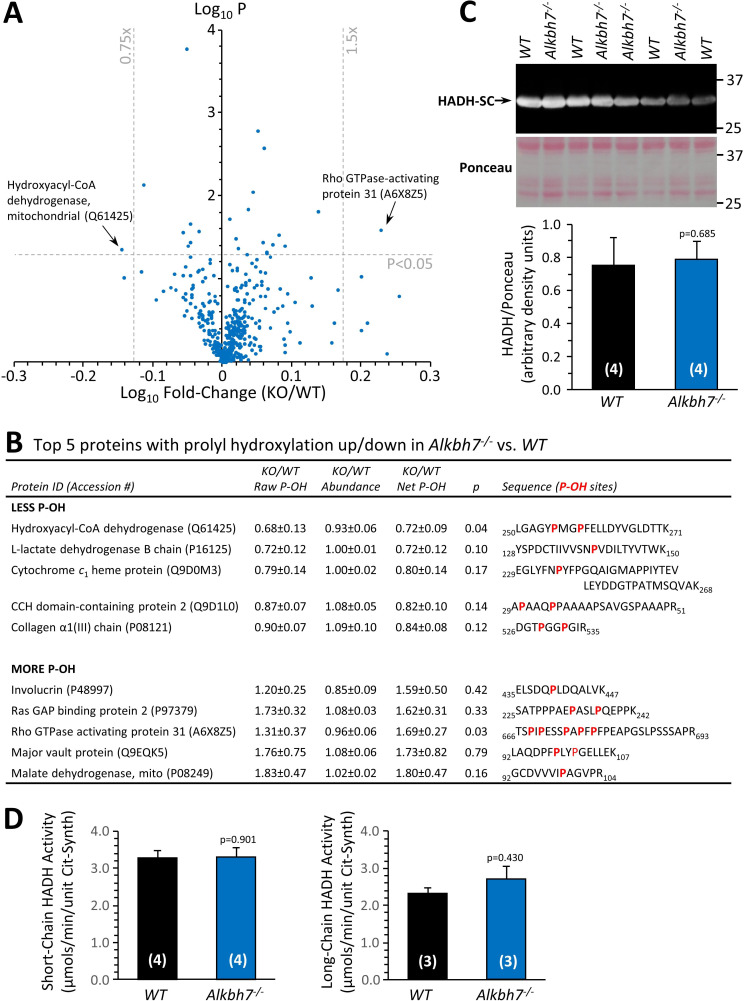
Proteomic analysis of prolyl-hydroxylation in WT vs.Alkbh7-/-.Hearts from young male WT or Alkbh7-/- mice were analyzed by tandem mass tag LC-MS/MS as per the methods. Abundance of each P-OH peptide was normalized to the abundance of its parent protein. (A) Volcano plot showing relative levels of 451 P-OH containing peptides. X-axis shows Log10 of fold change (Alkbh7-/- / WT) and Y-axis shows Log10 of significance (paired t-test, N = 5). Proteins crossing thresholds (gray lines) in upper left or right quadrants are labeled. (B) Table showing the top 5 P-OH containing peptides exhibiting increased or decreased relative abundance in Alkbh7-/- vs. WT. Table shows raw abundance of each P-OH peptide, abundance of the parent protein, and normalized abundance of the P-OH peptide. Annotated sequences highlight the hydroxylated proline residues in red. (C) Western blot showing abundance of HADH-SC (Hadh) in WT or Alkbh7-/- heart mitochondria with quantitation below, normalized to protein loading determined by Ponceau S stained membrane. (D) Spectrophotometric activity assays of short-chain and long-chain HADH in WT or Alkbh7-/- heart mitochondria. Bar graphs in panels C/D show means ± SE, N = 3–5, with p-values (paired t-test) shown above error bars. In bar graphs, N for each group is shown in parentheses.